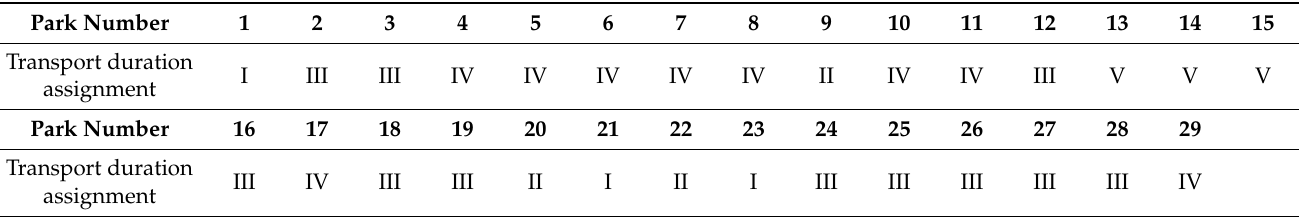
Table 15. The results of transport duration assignment of country